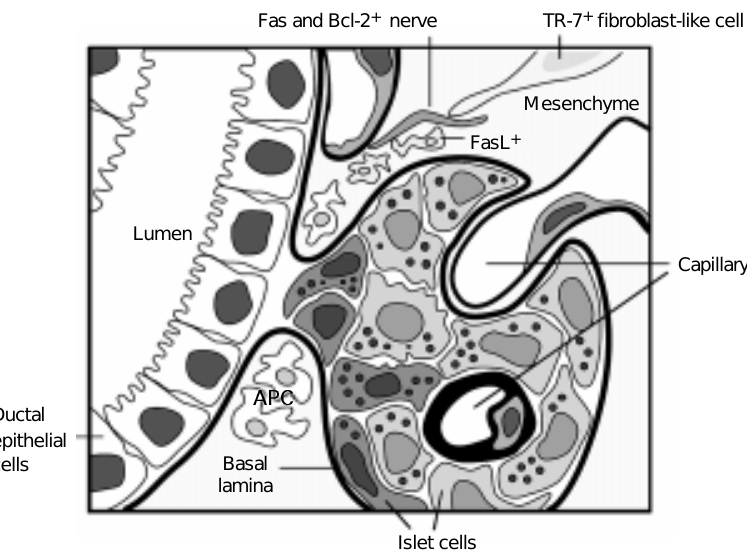
Figure 4 - Antigen-presenting cells (APC) as candidates for tissue remodeling phenomena (ECM synthesis/degradation, apoptosis) during islet neogenesis. Adapted from Pictet and Rutter